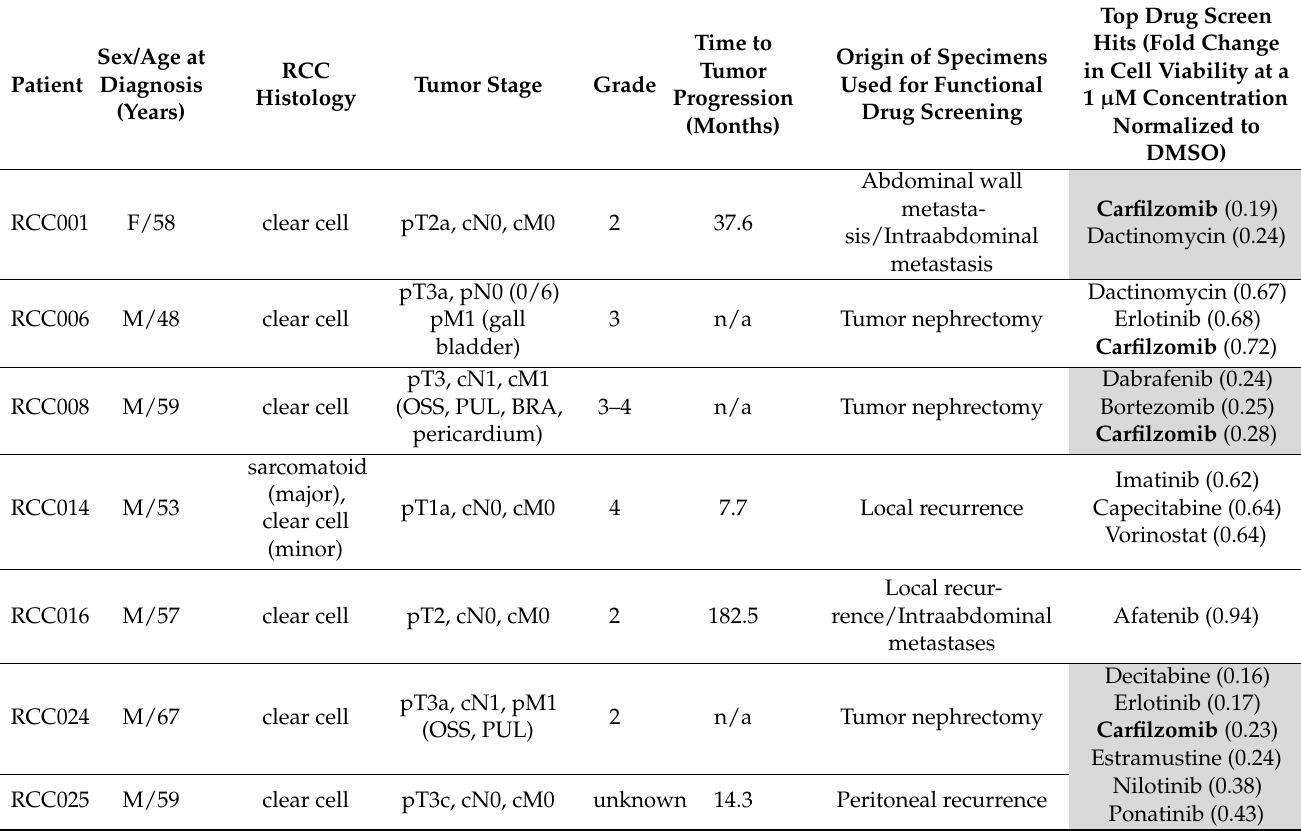
Table 1. Patient characteristics and in vitro drug screening